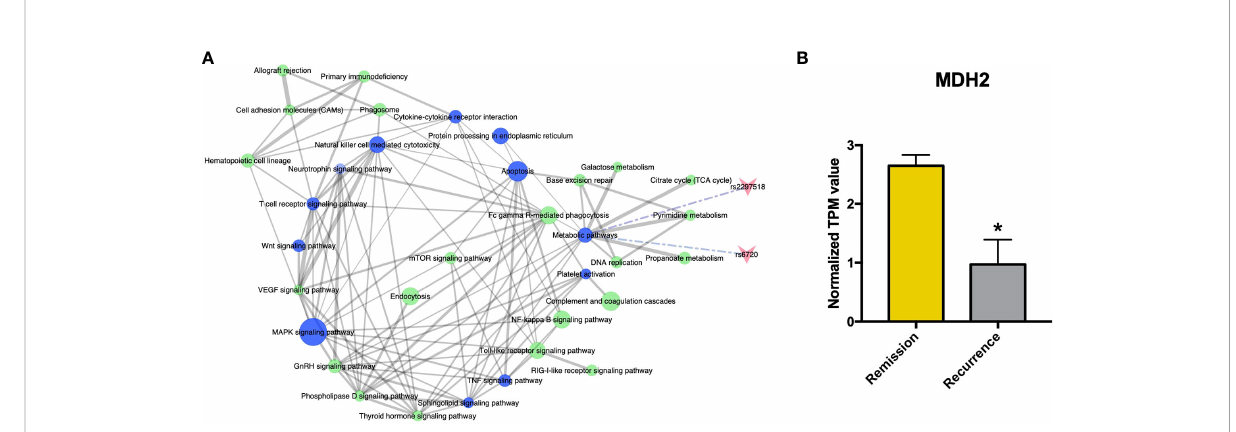
FIGURE 4 Crosstalk analysis among signi fi cantly enriched pathways suggested homozygous c.26C>T variant in MDH2 as a potential pathogenic mutation. (A) Pathway crosstalk among rFSGS related pathways. Triangular arrow represent SNPs, blue nodes represents pathways involving SNPs, green nodes represent pathways without SNPs involvement. Solid line represents crosstalk between each pair, Edge-width corresponds to the score of speci fi c pathway pair. Larger edge-width indicates higher score. Dotted line represents SNPs enrichment. (B) mRNA expression level of MDH2 in remission group and recurrence group. *p